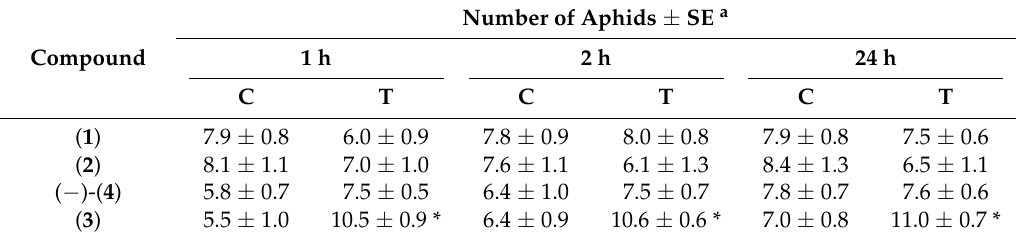
Table 3. Settling success of Myzus persicae on leaves treated with dihydrojasmone ( 1 ) and alkyl-substituted δ -lactones ( 2 ), ( 3 ), and ( − )-( 4